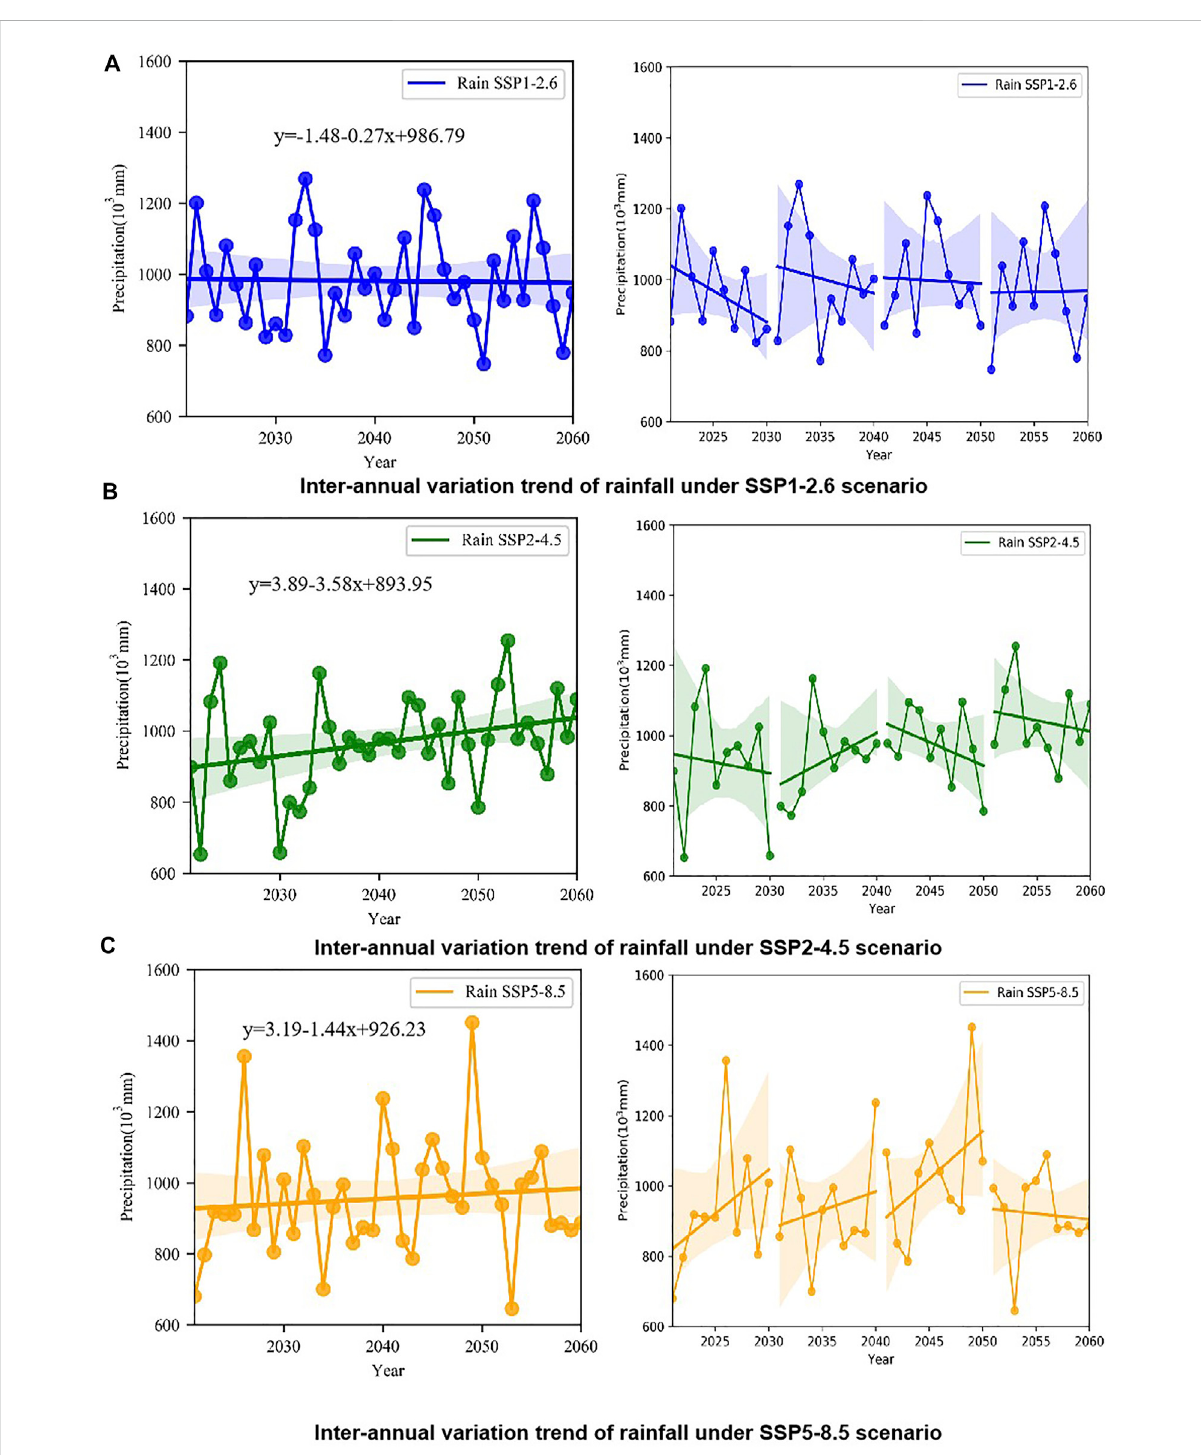
FIGURE 8 Inter-annual variation trend of future rainfall under three scenario. (A – C) are the inter-annual variation of rainfall under SSP1-2.6, SSP2-4.5 and SSP5-8.5 scenarios